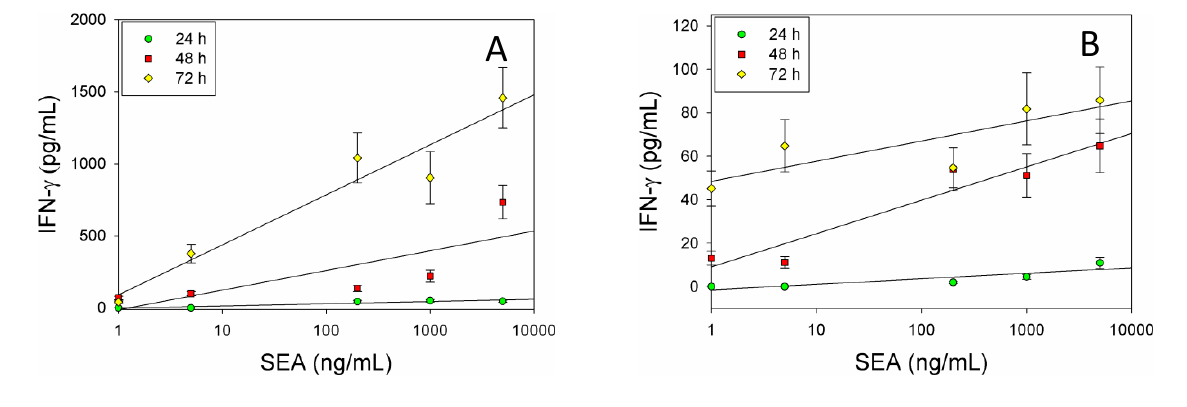
Figure 2. Flow cytometric analysis of IFN-γ protein secretion by splenocytes ( A ) or CD4 + T-cells ( B ) after exposure to biologically active SEA. Splenocytes were spiked with increasing concentrations of SEA. After 24, 48 or 72 h of stimulation with SEA, IFN-γ protein secretion was measured by flow cytometry. Linear regression fits to the data are shown and error bars represent standard errors for each set of data